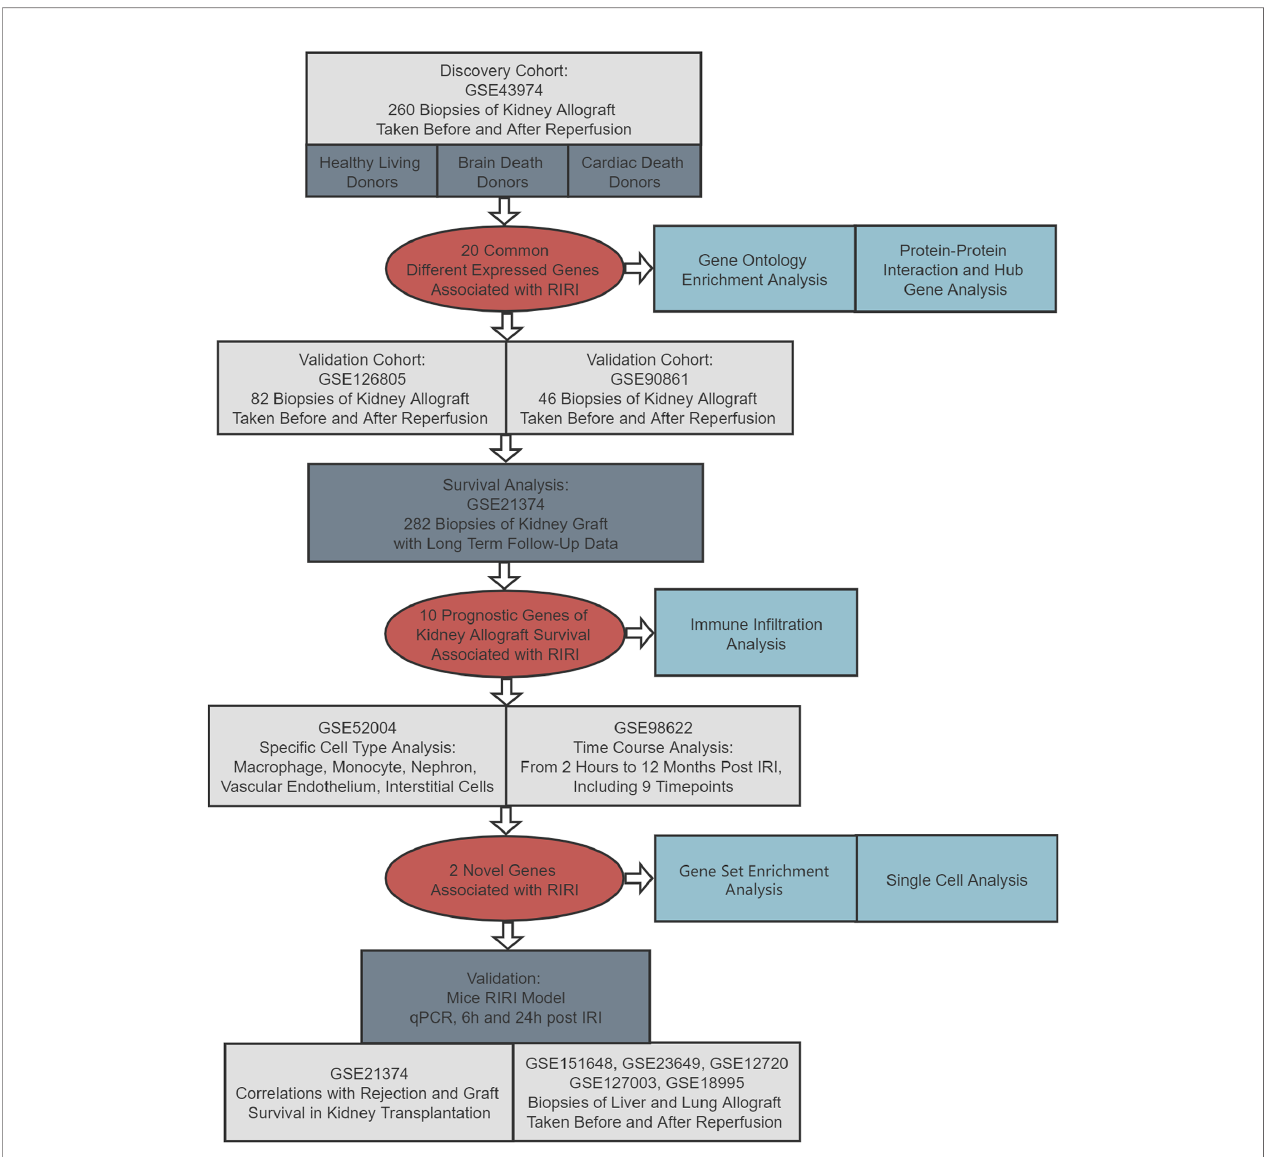
FIGURE 1 | Flowchart of this study. RIRI: renal ischemia – reperfusion injury, IRI: ischemia – reperfusion injury, qPCR: quantitative polymerase chain